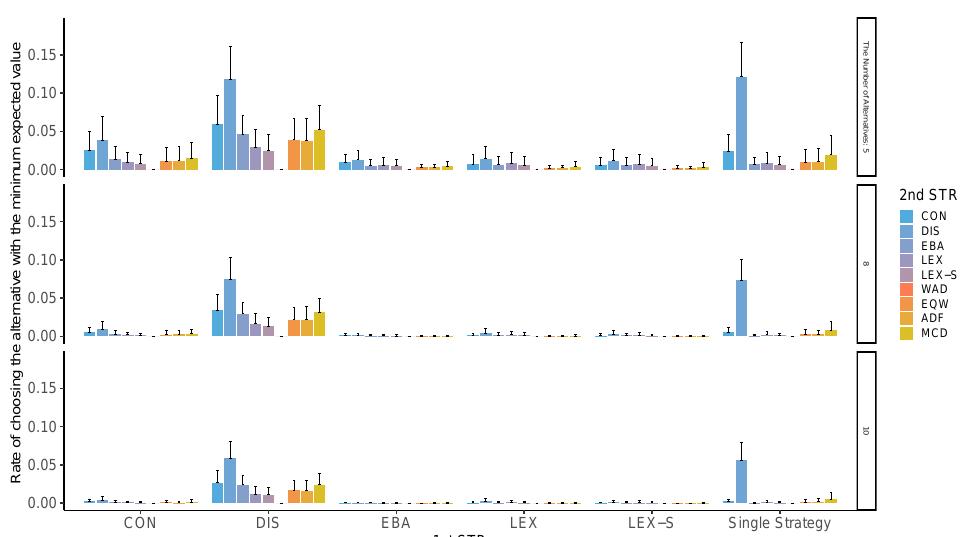
Figure A9. Worst-choice rate in two-stage decision-making when only two alternatives are left in the second stage. Note: ADF: additive difference; CON: conjunctive; DIS: disjunctive; EBA: elimination by aspects; EQW: equal-weighted strategy; LEX: lexicographic; LEX-S: lexicographic semi-order; MCD: majority of confirming dimensions; STR: strategy; WAD: weighted additive.